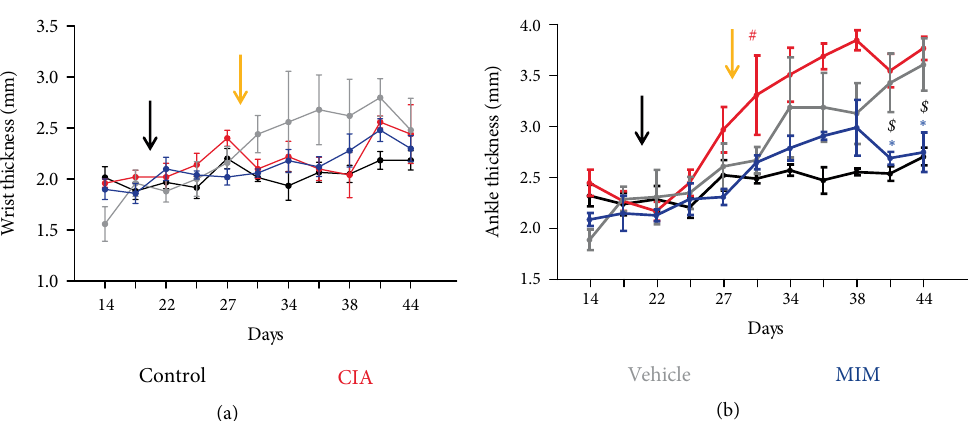
Figure 2: Variations in wrist and ankle thickness. (a) Wrist and (b) ankle thickness (mm) were measured every 3-4 days using a caliper. The black arrow indicates the reimmunization day, while the yellow arrow the beginning of the treatment with vehicle or MIM in their respective group. ∗ 푃 < 0.05 vs. vehicle-treated group; $ 푃 < 0.01 vs. untreated CIA group; # 푃 < 0.05 vs. control group.